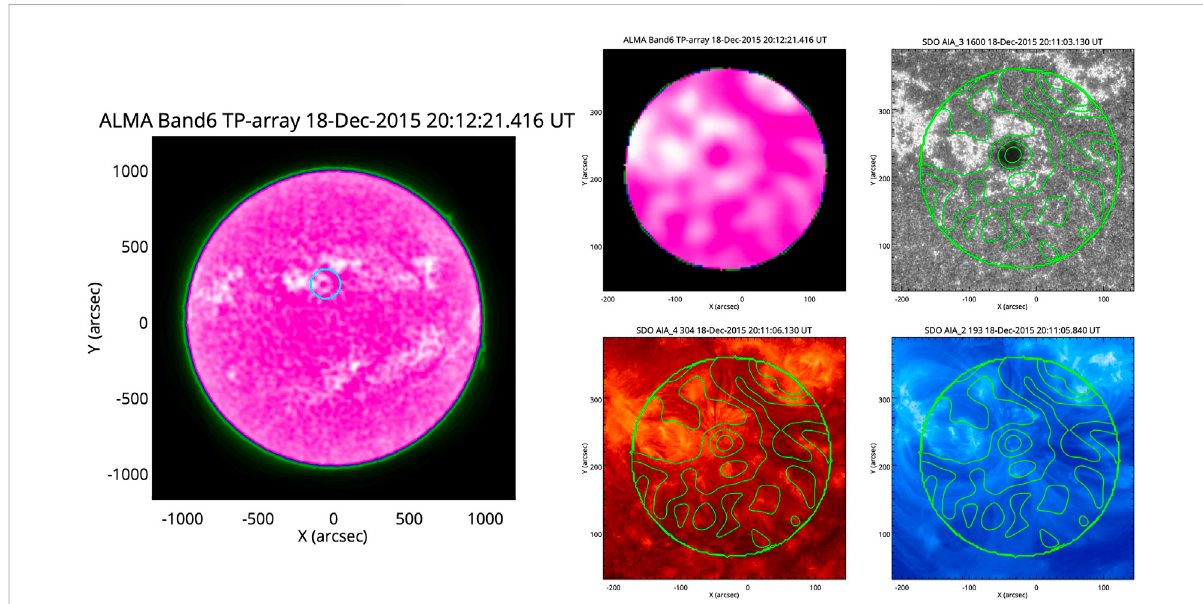
FIGURE 3 SimulatedFRMdata.Leftpanel:FulldiskTPimageobtainedwithBand6on18December2015.Thecircleindicatesthe fi eldofviewofFRMwith 300 ″ diameter. Right panels:SimulatedFRM image and UV/EUV images. Upper Left: SimulatedFRM image with 300 ″ diameter FoV. Upper Right: UV continuum (1700Å band). Lower Left: He II 304Å Band, Lower Right: Fe XII 193 Å Band. Green contours show the FRM image. Examples of a total power full disk map (left) and FRM map (middle, top). The Band 6 total power map was acquired during commissioning in December 2015. The FRM map was made using the TP map in